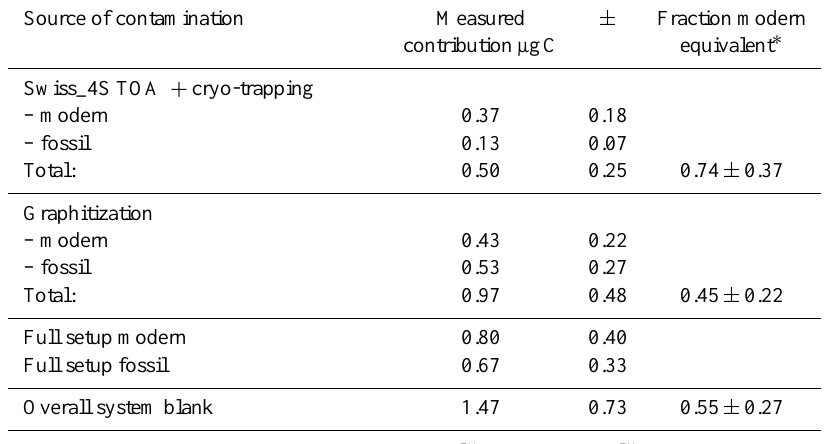
Table 2. Summary of the amounts and 14 C signatures of extraneous carbon introduced during the isolation and graphitization of OC and EC standard materials at UC